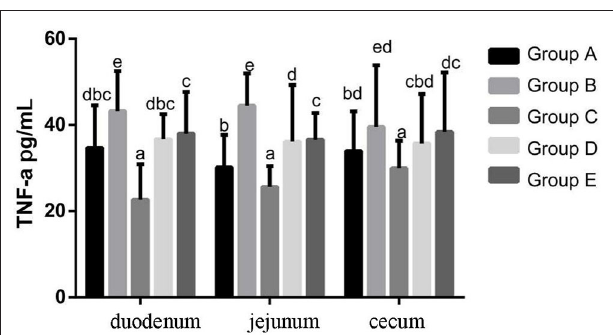
FIGURE 9 | Expression of sIgA Protein in Duodenum, Jejunum and Caecum in different treatment groups. Group A, control group; Group B, infection group; Group C, JYBR-190 pre-fed group; Group D, JYBR-190 fed group; Group E, antibiotic group. Data are expressed as mean ± standard deviation (SD). Different lowercase letters on the columns indicate significant differences ( P < 0.05); the same lowercase letters indicate no significant difference ( P > 0.05).